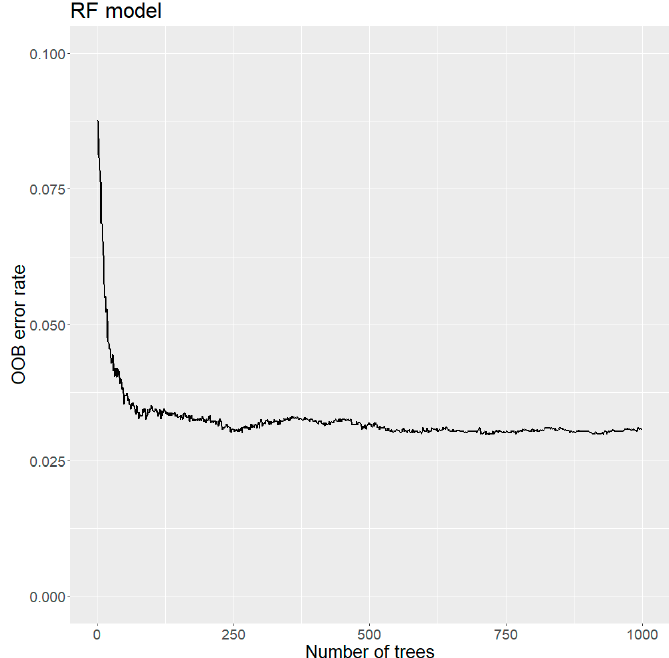
Figure 4. The relationship between out-of-bag (OOB) error rate and number of trees (ntree) in the random forest (RF) model for extracting the pre-land cover map.